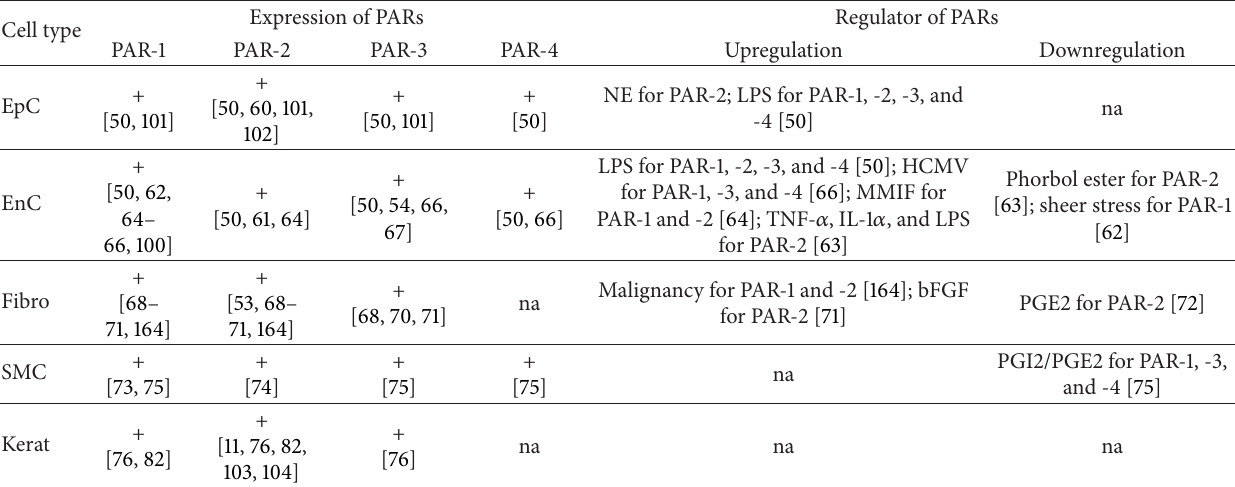
Table 2: Expression of protease activated receptors (PARs) on structural